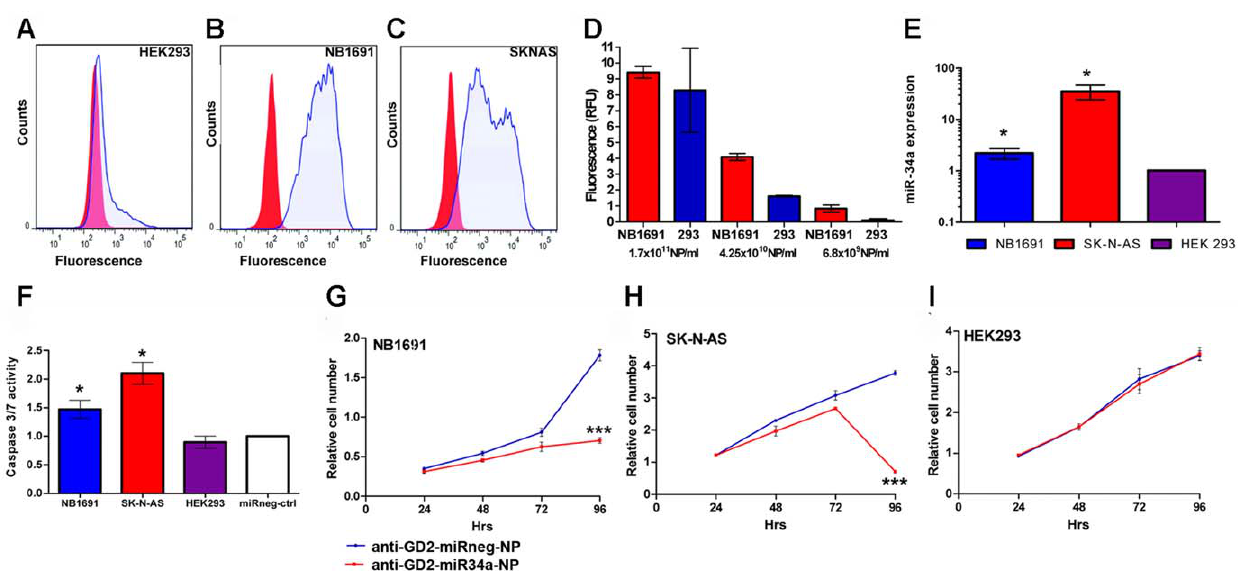
Figure 1. Specific uptake of anti-GD 2 -nanoparticles exclusively by GD 2 expressing cells. Effects on growth and caspase activity by anti- GD 2 conjugated nanoparticles containing miR-34a. (A) FACS analysis, using an anti-GD 2 primary antibody and goat anti-mouse IgG2a-PE secondary antibody indicated little, if any, GD 2 surface antigen on HEK293 cells. Conversely NB1691 (B) and SK-N-AS (C) cells showed significant GD 2 reactivity. (D) Varying concentrations of FITC-anti-GD 2 -NPs were added to cell culture media of NB1691 or HEK293 (1 6 10 6 cells). A concentration of 6.8 6 10 9 particles/ml (40 m g/ml) was the optimal dosage tested in vitro for specific delivery of encapsulated FITC fluorophore to NB1691 neuroblastoma cells with minimal incorporation into HEK293 cells. (E) Anti-GD2-miR34a or control-anti-GD2-nanoparticles were added to adhered neuroblastoma SK-N-AS and NB1691, and to HEK293 cells for 4 hours in standard media. Media was removed, the cells washed and media was replaced. RNA was isolated from these cells after 24 hours and assessed for miR34a levels. Anti-GD 2 -miR34a-NPs treatment (40 m g/ml) led to , 2 fold increase in miR-34a levels in NB1691 cells, , 30 fold increase in SK-N-AS cells (*p , 0.05, n=3), with no significant change in miR-34a transcript levels in HEK293 cells. (F) NB1691 and SK-N-AS cells showed a significant increase in caspase 3/7 activity relative to anti-GD 2 -miRneg-NP-treated cells after 72 hrs (*p , 0.05, n=3) while HEK293 cells showed no significant increase in caspase activity under these conditions. Acid phosphatase assays indicated a significant reduction in viable cell numbers for (G) NB1691 and (H ) SK-N-AS cells treated with anti-GD 2 -miR34a-NPs, over a 96 hour period (***p , 0.001) relative to anti-GD 2 - miRneg-NP-treated controls. (I) HEK293 cells showed no significant reduction of viable cells following treatment with anti-GD 2 -miR34a-NP (p . 0.05,